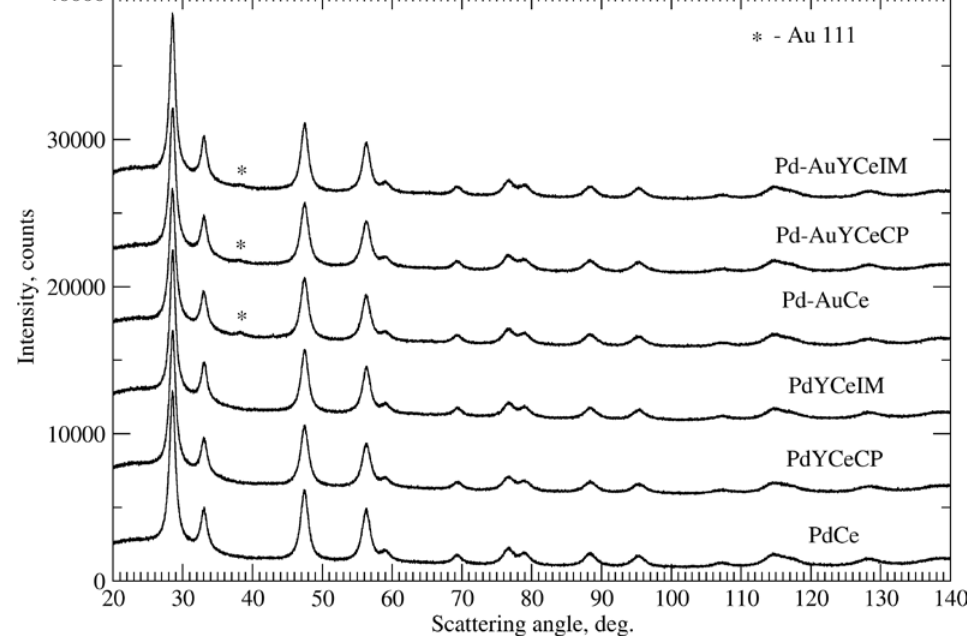
Figure 2. XRD patterns of the Pd containing catalysts.